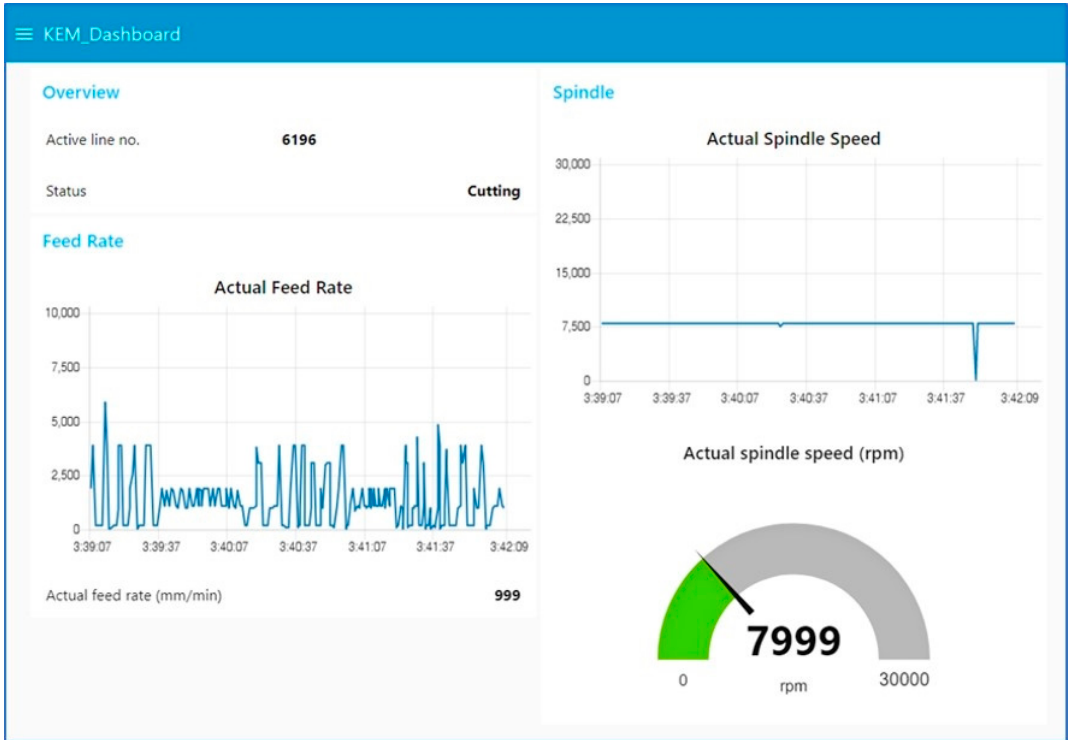
Figure 10. Online dashboard of monitoring from the KEM server.